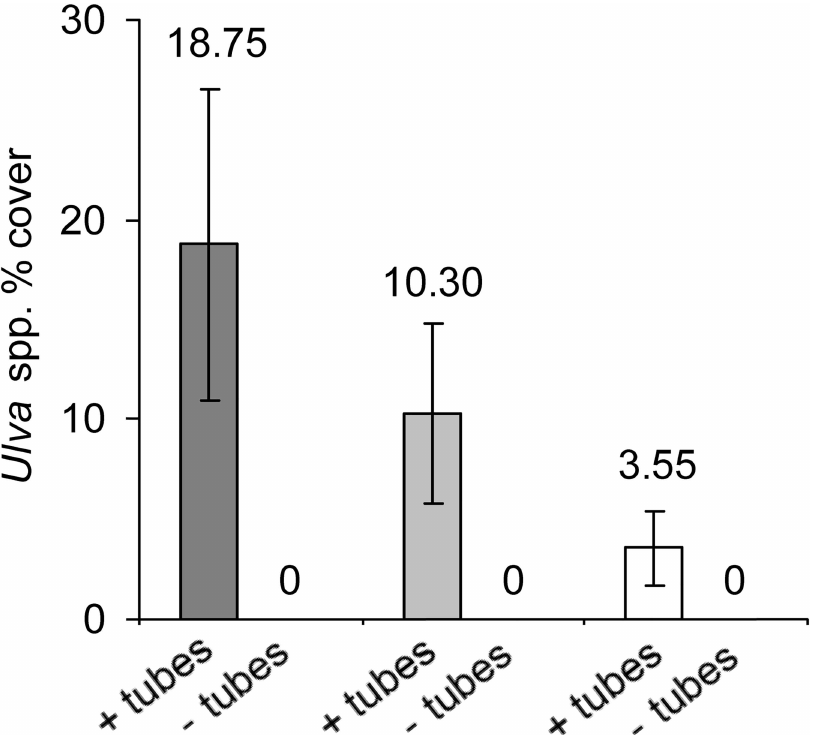
Fig 3. Ulva algae is present on boulders with worm-tubes and absent from boulders without. Mean ( ± SE) percentage cover of Ulva spp. on boulderswith and without calcareous tubes of serpulimorph polychaetes. Dark grey bars are from Site 1, light grey from Site 2, and white from Site 3; n = 10.